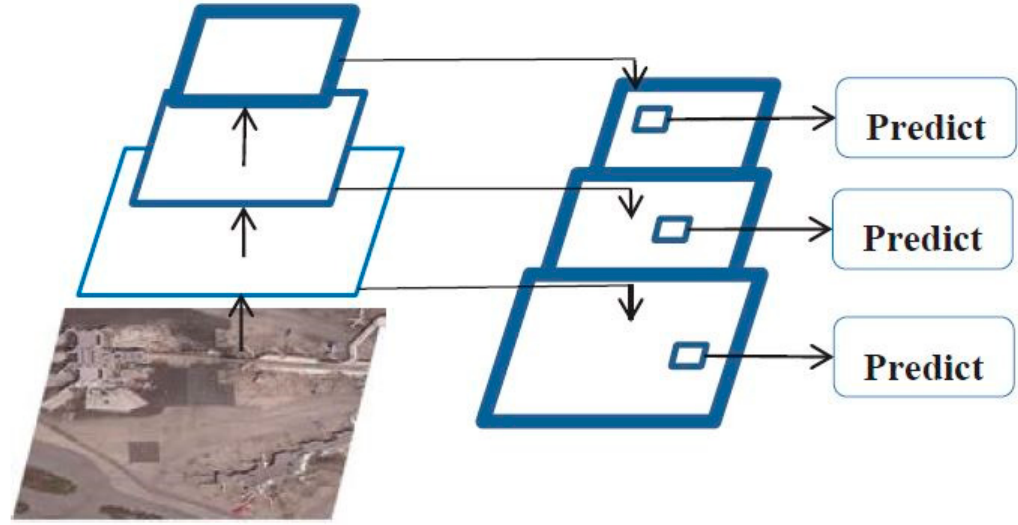
Figure 1. The schematic diagram of multi-scale prediction.